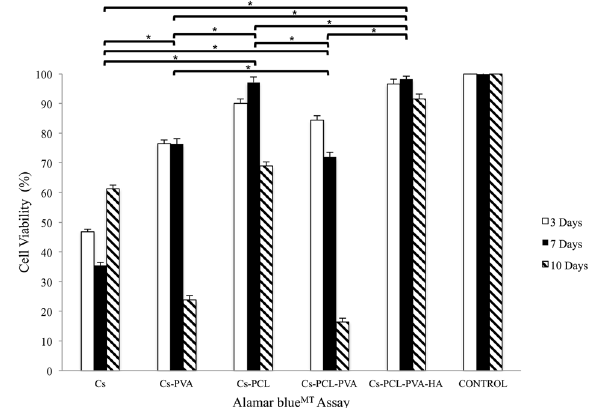
Fig. 4 Thermogravimetric analysis of biomaterials